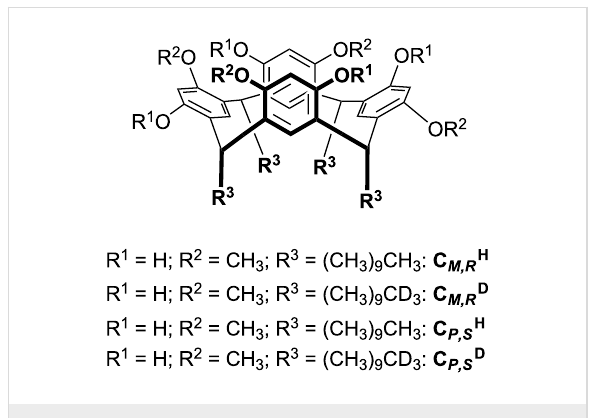
Figure 10: Cyclochiral resorcin[4]arenes.